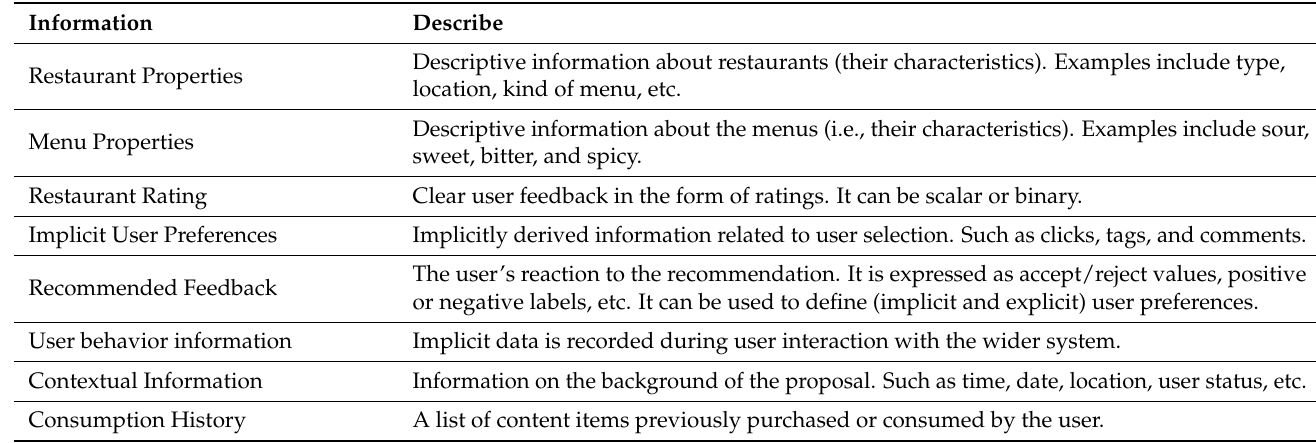
Table 3. A summary of the types of data information used by the recommender